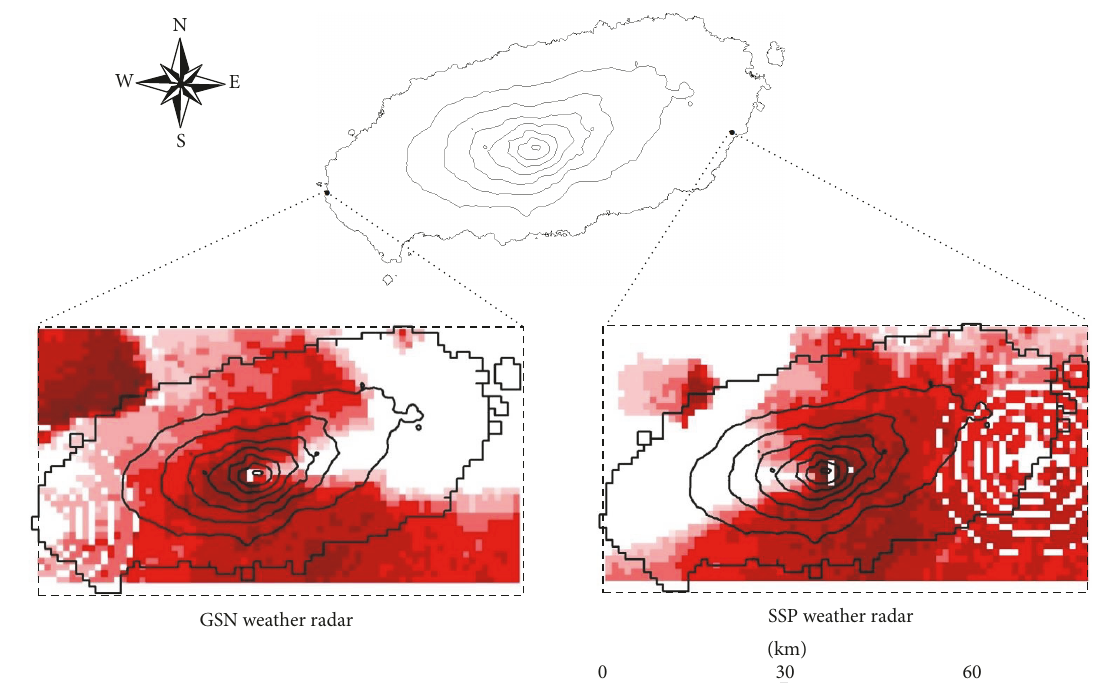
Figure 3: Location of the Gosan and Seongsan radars and their radar beam blockages for the 1.5 km CAPPI data (during the Typhoon Nakri, 07:00 Aug. 2,